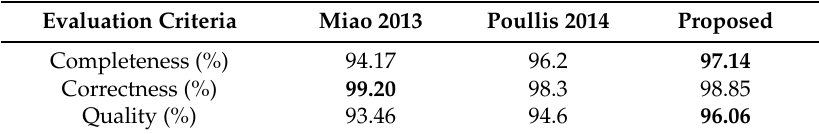
Table 1. Quantitative comparison of the proposed method with two state-of-the-art approaches in the first study area. The highest values with respect to the evaluation criteria are